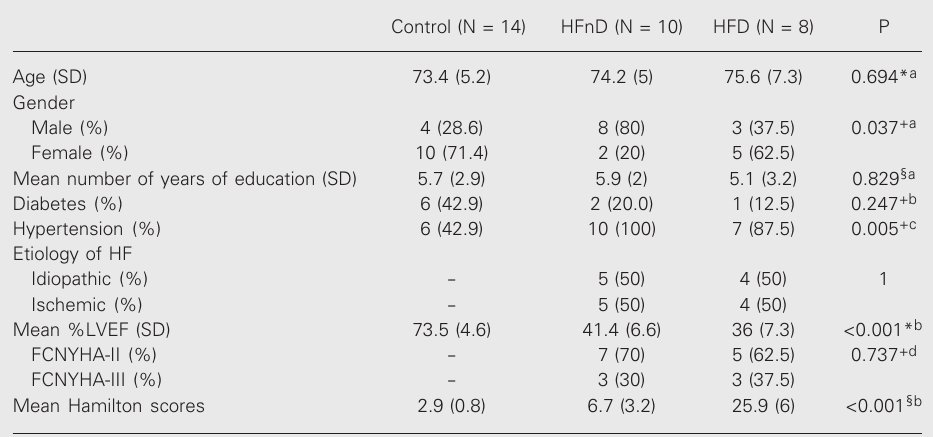
Table 1. Demographic and clinical variables of depressed and non-depressed subjects with heart failure and control